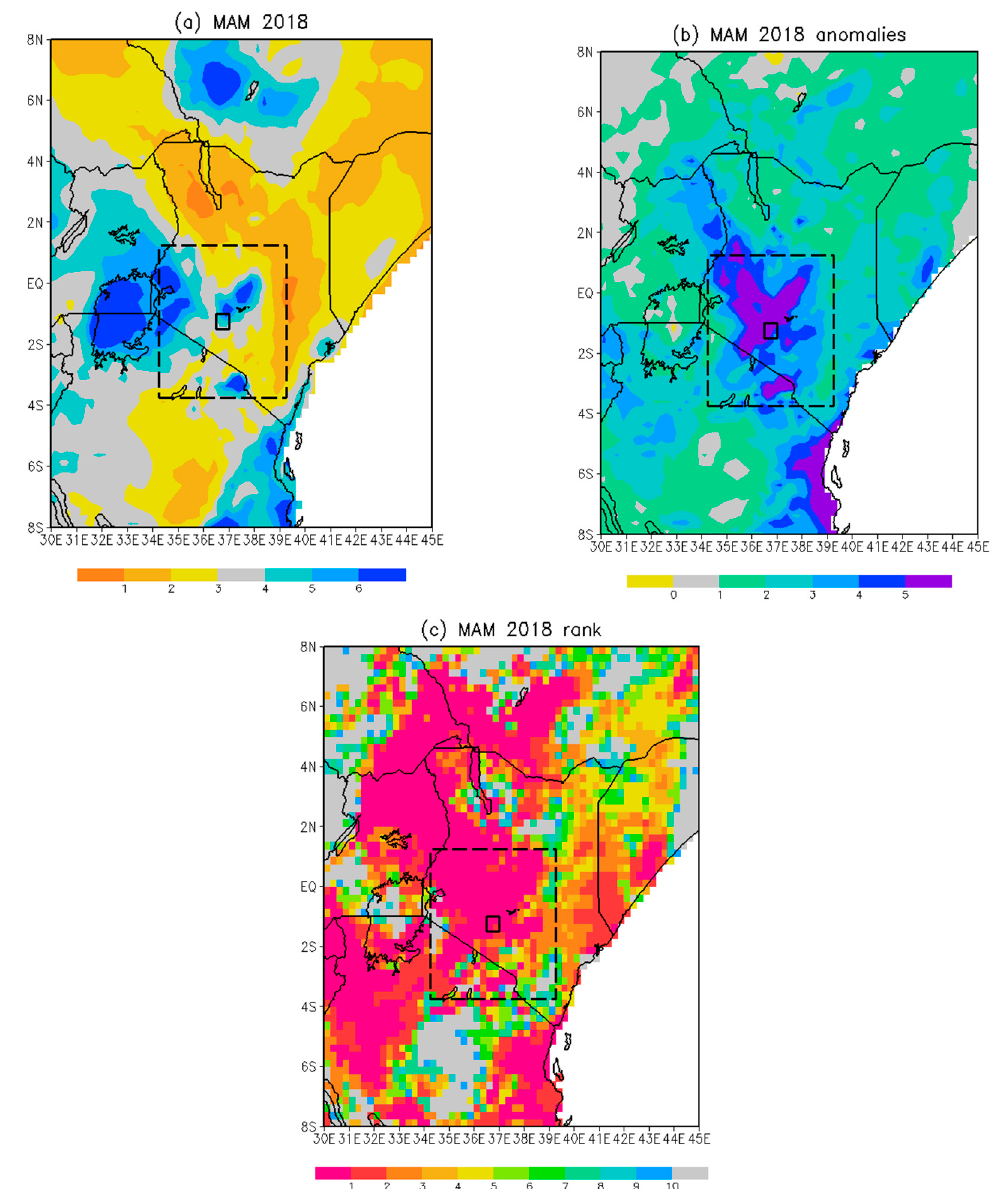
Figure 2. Rainfall over East Africa during March, April, and May (MAM) 2018 from Climate Hazards InfraRed Precipitation with Station Data (CHIRPS) data ( a ) Mean MAM rainfall 1981–2010 (mm day − 1 ). ( b ) Absolute anomalies (mm day − 1 ). ( c ) The rank of the MAM 2018 season within the 117-year CenTrends data. The large black dashed, and smaller solid squares, indicate the Kenya-core and Nairobi regions, respectively, which are used for areal averaging.